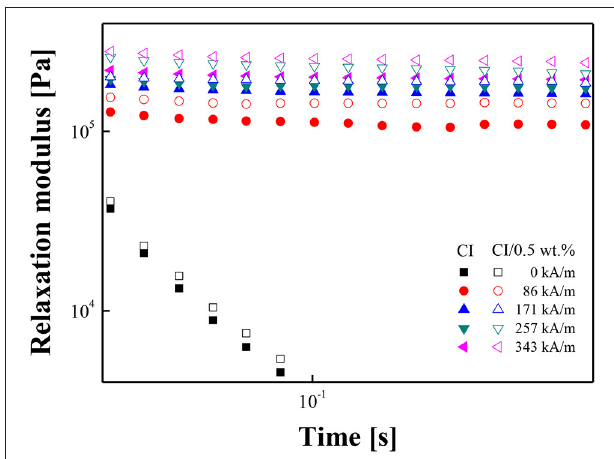
FIGURE 8 | Relaxation modulus of the pure carbonyl iron (CI; closed symbol) and CI/BaFe 12 O 19 (open symbol) -based MR fluids as a function of time.